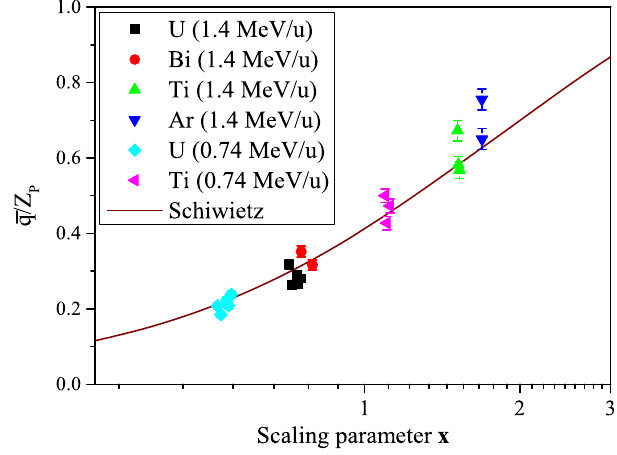
FIG. 13. Measured data plotted as ratio of the mean charge state to the atomic charge of the projectile ion against the scaling factor x , as described in the text, and compared to estimations by the Schiwietz formula